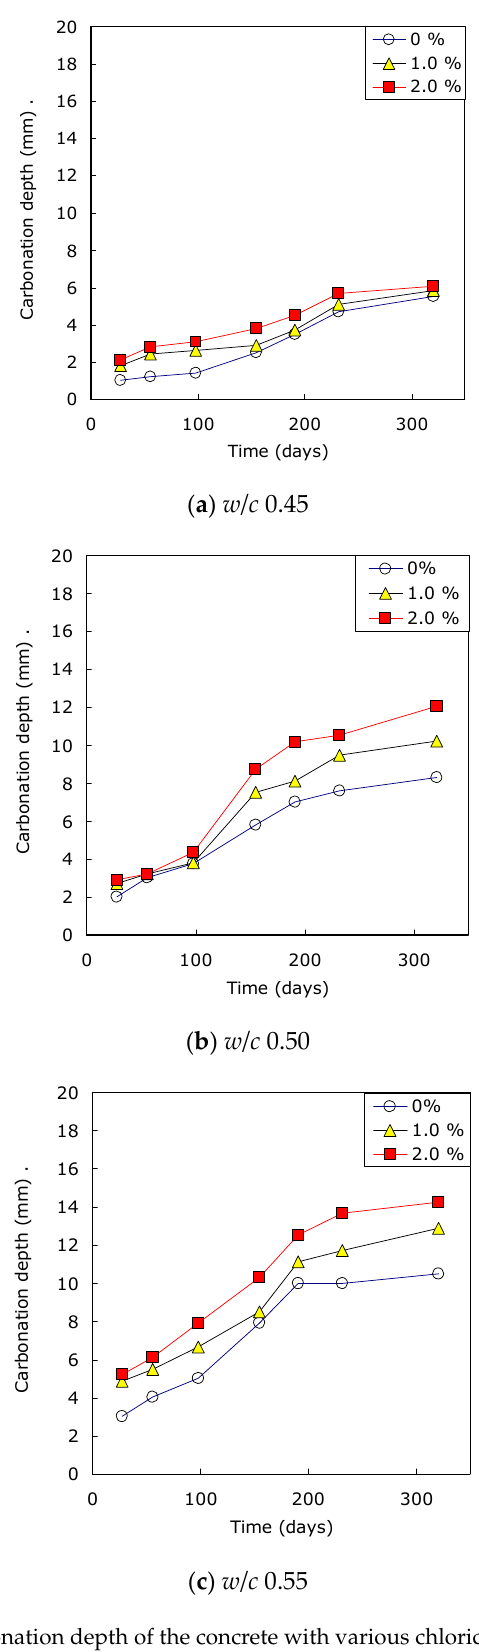
Figure 13. Carbonation depth of the concrete with various chloride concentrations.